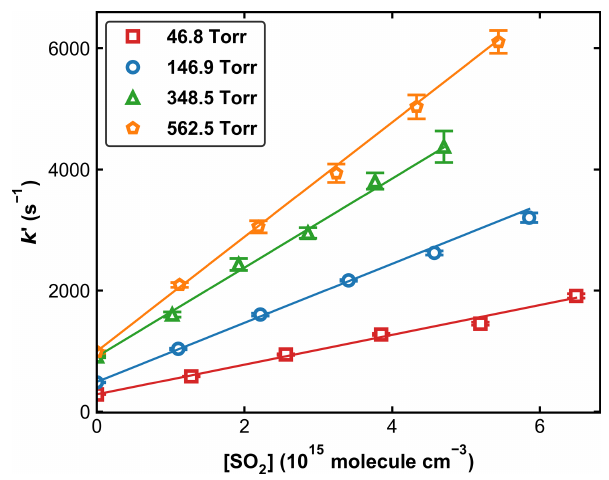
Figure 5. Pseudo-first-order rate coefficients ( k (cid:48) ) as a function of the SO 2 concentration ([SO 2 ]) at four different pressures at 298K. Error bars represent 2 σ statistical uncertainty. The lines are weighted, linear regressions.